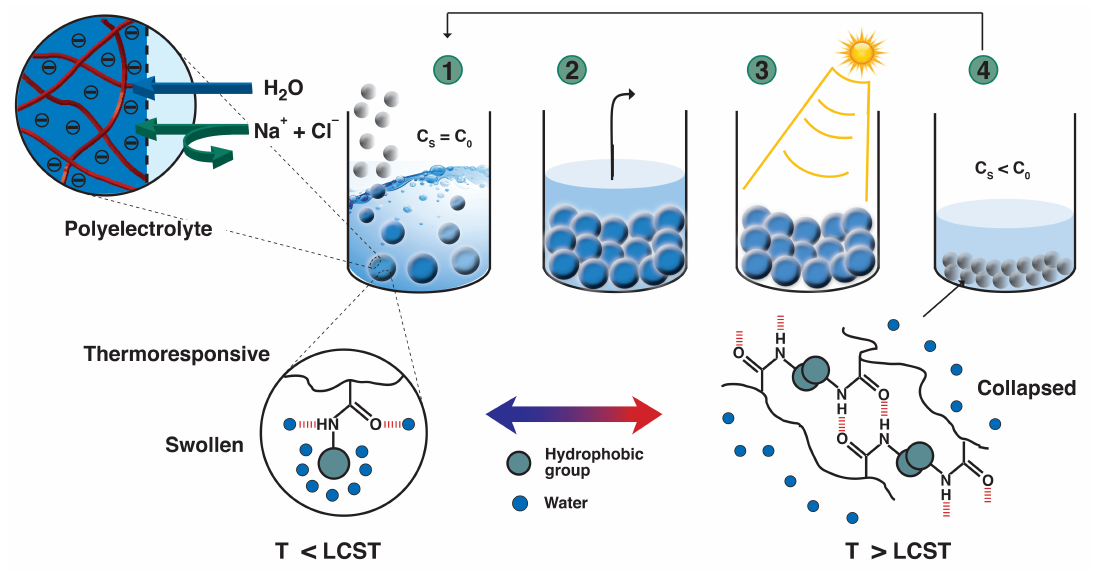
Figure 1. Scheme of the envisioned four steps of the desalination process, where (1) is swelling of the hydrogel in an excess of brine solution with concentration C S at which the mobile ions of the brine solution are partly rejected from the hydrogel ( left ), (2) removal of the excess brine solution, (3) dewatering of the hydrogel by means of a thermal energy source, the water is released from the hydrogel due to the phase separation of PNIPAAm above its LCST ( down ), (4) collection of salt depleted water with brine concentration less than initial one ( C S < C 0